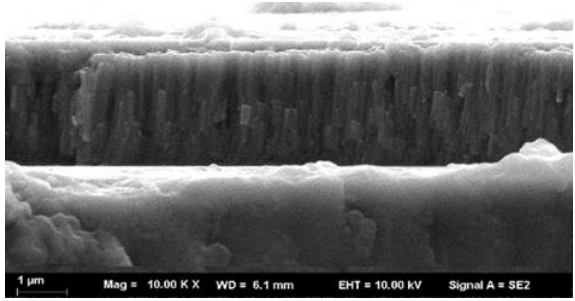
Figure 1. Cross-sectional SEM image of Mo 2 N film.